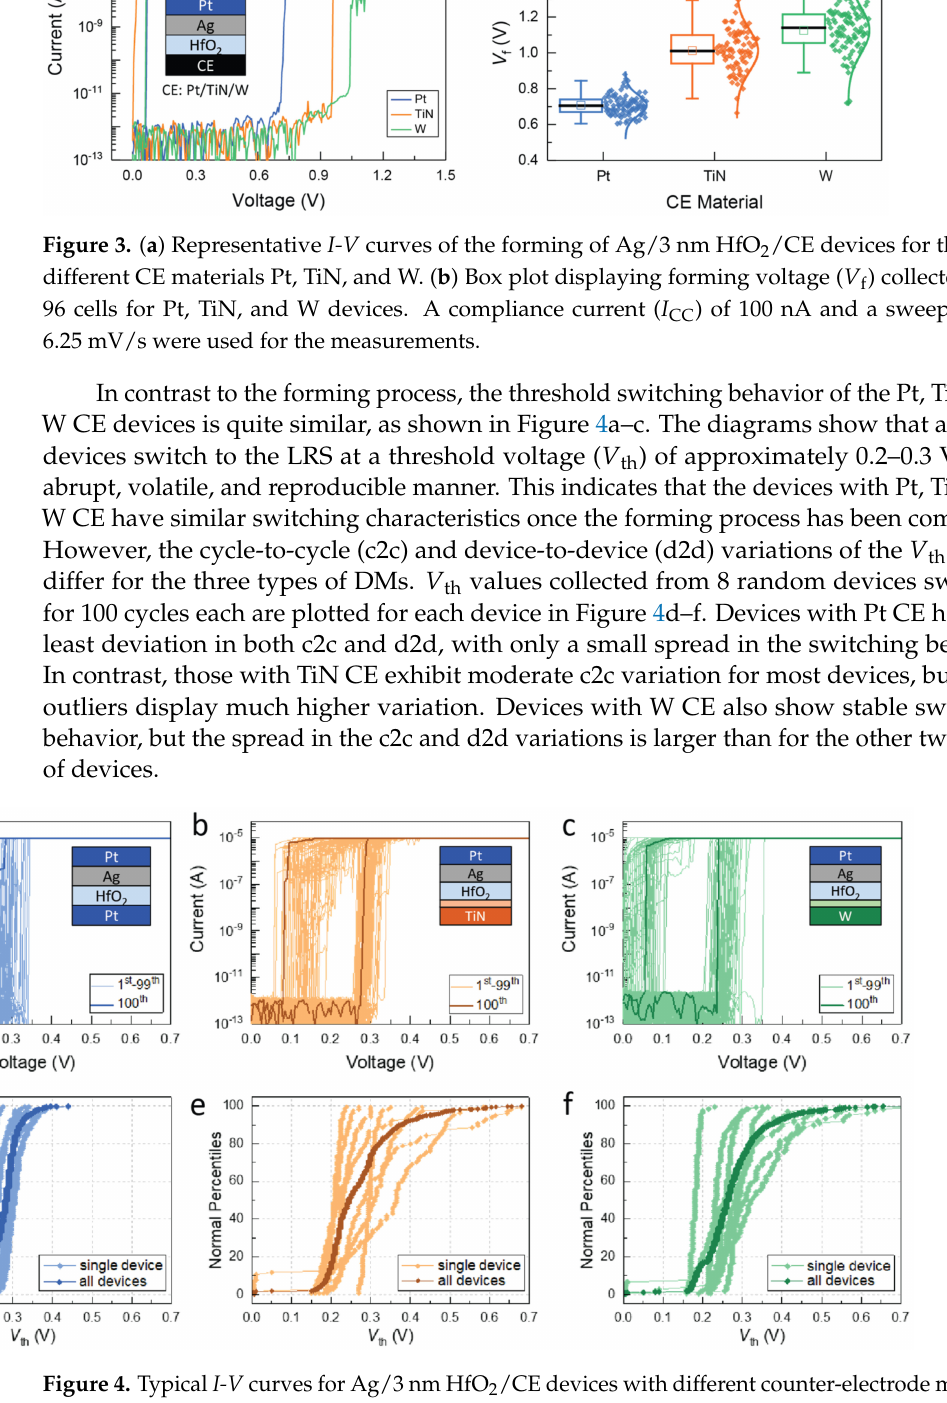
Figure 4. Typical I-V curves for Ag/3 nm HfO 2 /CE devices with different counter-electrode materials of ( a ) Pt, ( b ) TiN, and ( c ) W. Statistics of the threshold voltage ( V th ) collected from 8 devices and 100 cycles each for ( d ) Pt, ( e ) TiN, and ( f ) W CE. The TiO x and WO x interfacial oxides are shown with light orange and light green colors, respectively. A sweep rate of 6.25 mV/s was used for the